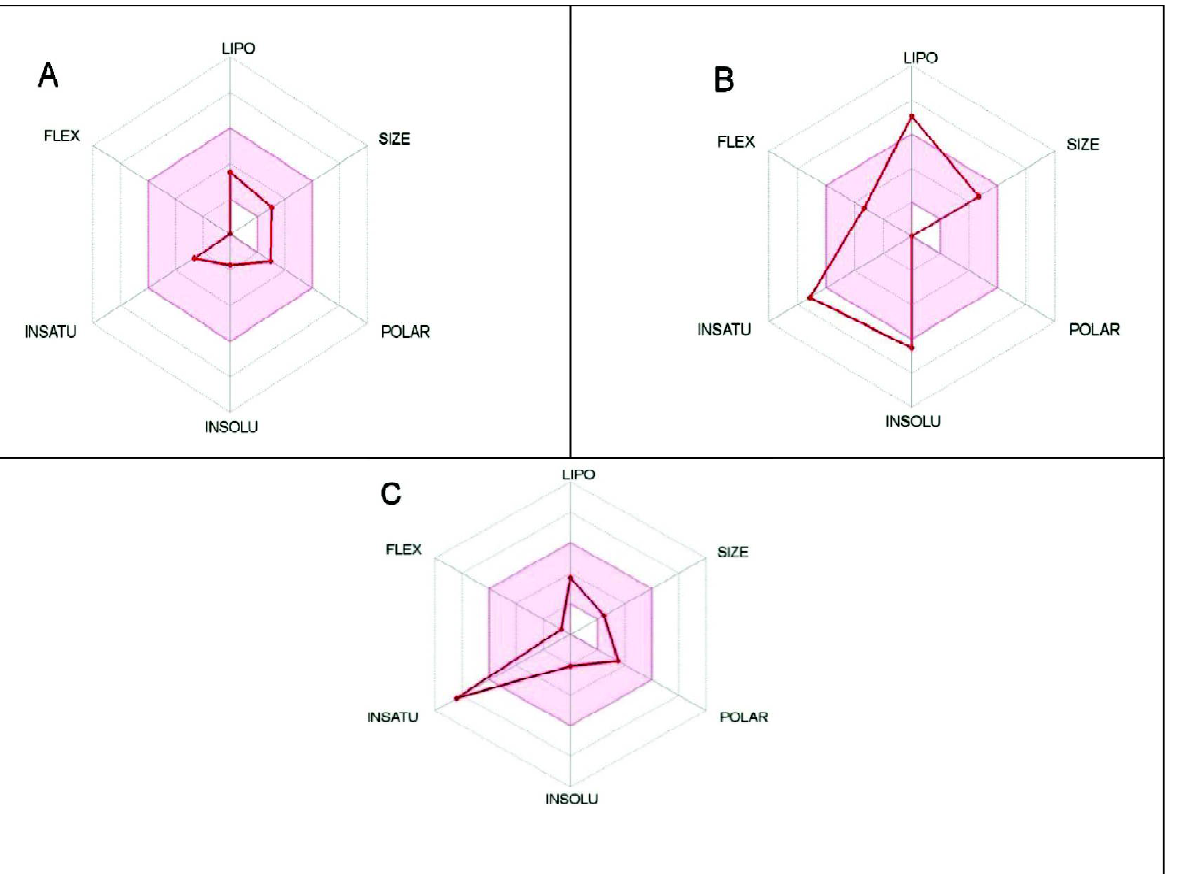
Figure 2: Bioavailability radar illustrations: (A) Loliolide (L5); (B) Resveratrol derivative-4 (R4); and (C) Scopoletin